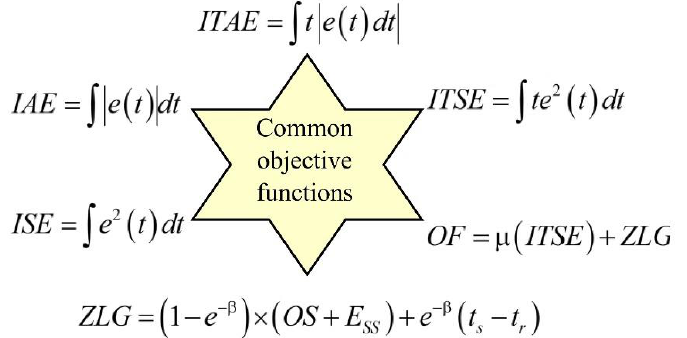
Figure 3. The most frequently used objective functions in estimating regulator parameters in AVRs.